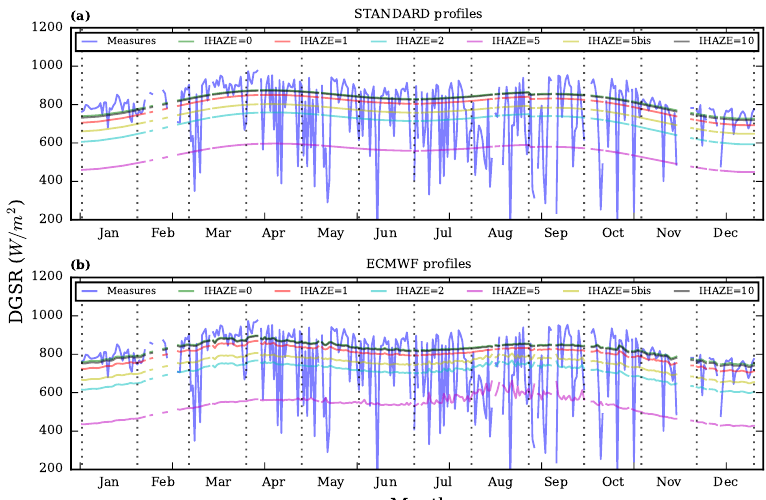
Figure 6. Representation of clear-sky downward global solar radiation (DGSR) simulated with ( a ) a standard atmosphere and ( b ) the insertion of European Center for Medium-Range Weather Forecasts (ECMWF) atmospheric profiles in Maroua in 2014. Simulations were done for six moderate-resolution transmittance (MODTRAN) default aerosol models. Corresponding DGSR measured is also represented for both cloudless and cloudy days. Vertical dashed lines represent month